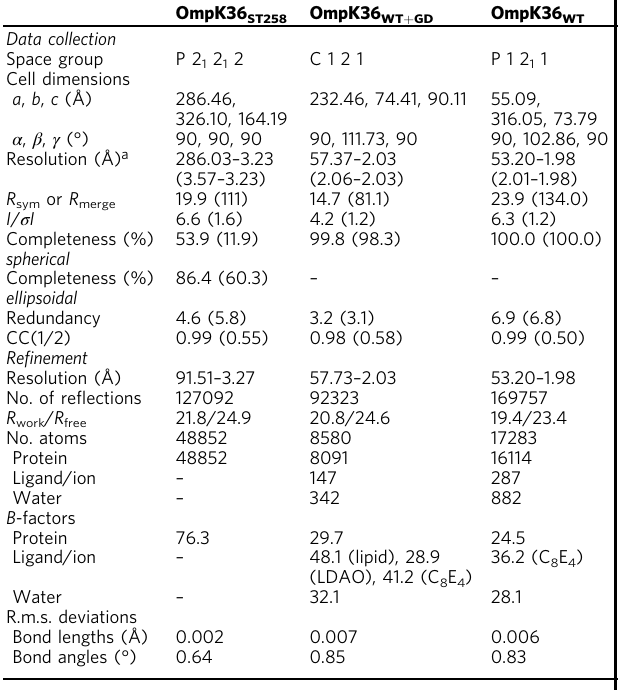
Table 2 Data collection and re fi nement statistics OmpK36 ST258 OmpK36 WT +